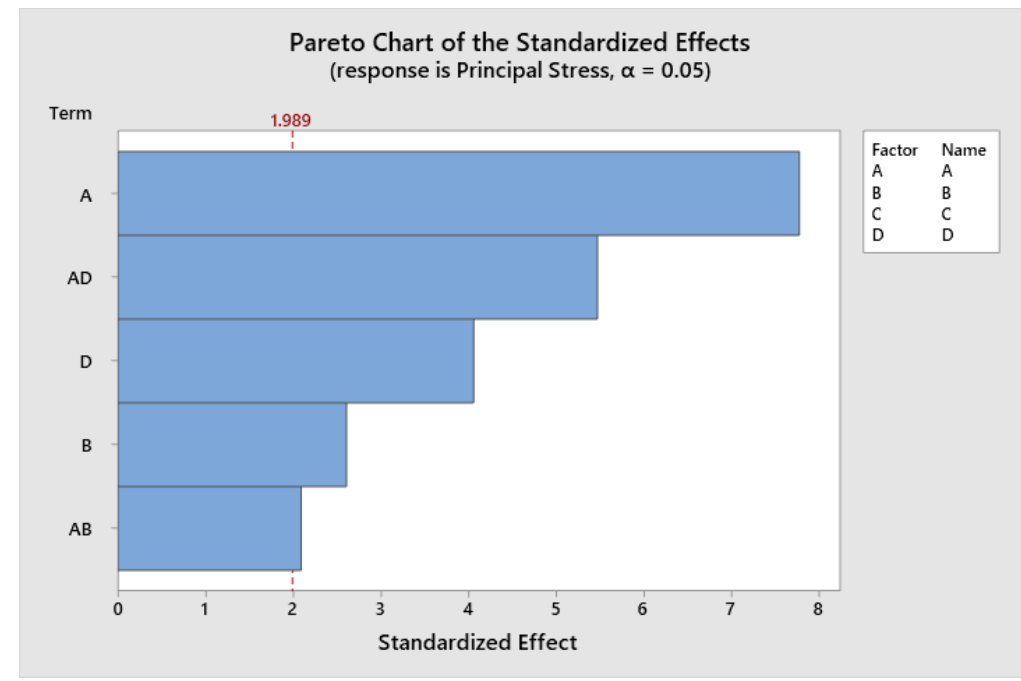
Figure 10. Pareto chart of the effects of principal stress (four locking screws).